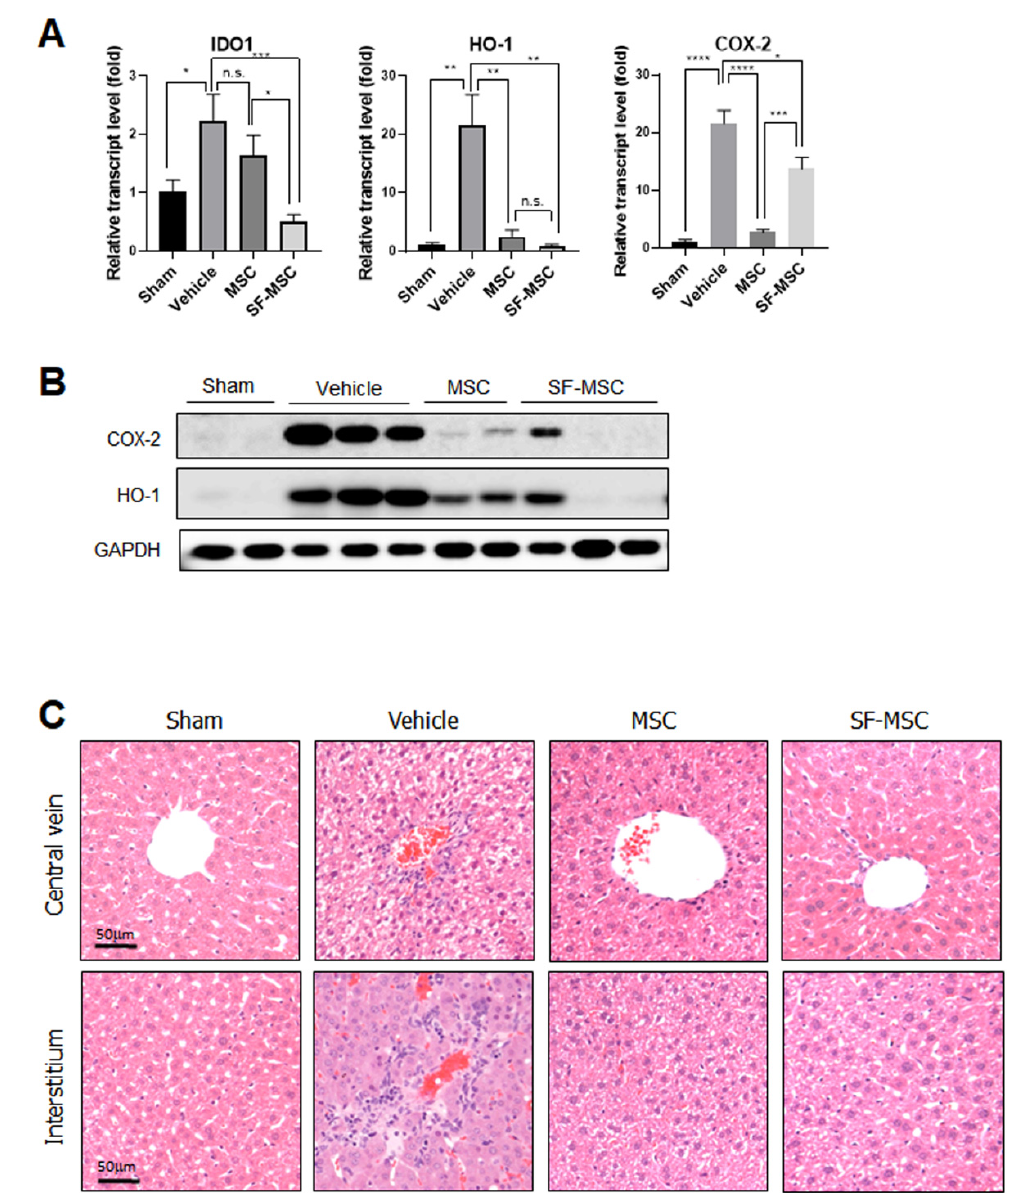
Figure 4. Primed MSCs on both the control surface and the SF nanofibers ameliorate inflammation-related protein expression in septic mice. ( A ) Liver tissue was isolated for the qPCR analysis of the mice’s IDO-1, HO-1 and COX-2 genes ( n = 4 independent experiments, one-way ANOVA, * p < 0.05, ** p < 0.01, *** p < 0.001, and **** p < 0.0001). ( B ) HO-1 and COX-2 protein expression were assessed in the mice’s liver tissue 5 days after sepsis ( n = 3 independent experiment). ( C ) The H&E staining method was applied on day 5 after sepsis. Scale bar = 50 µ